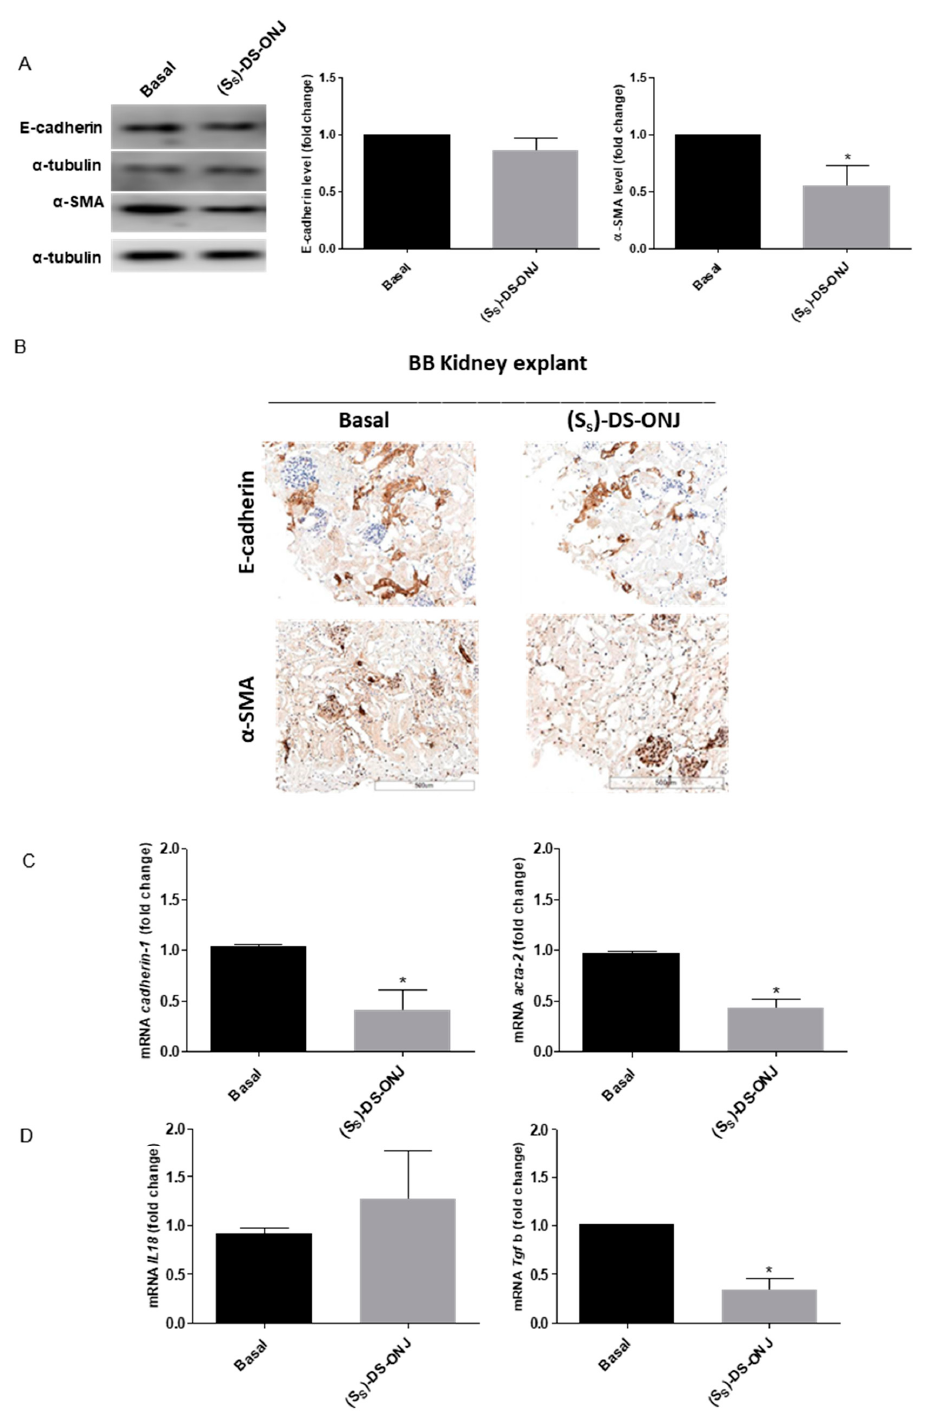
( Figure 8A–D). The treatment likely stopped the EMT progression. The critical point in EMT reversion was the reduction in Il18 expression and the ( S S )-DS-ONJ treatment did not reduce Il18 expression. An analysis of the specific transcriptional factors involved in EMT showed that, ( S S )-DS-ONJ reduced the protein levels of ZEB-1 but increased those of Snail (Figure 8E) in BB AK explants.